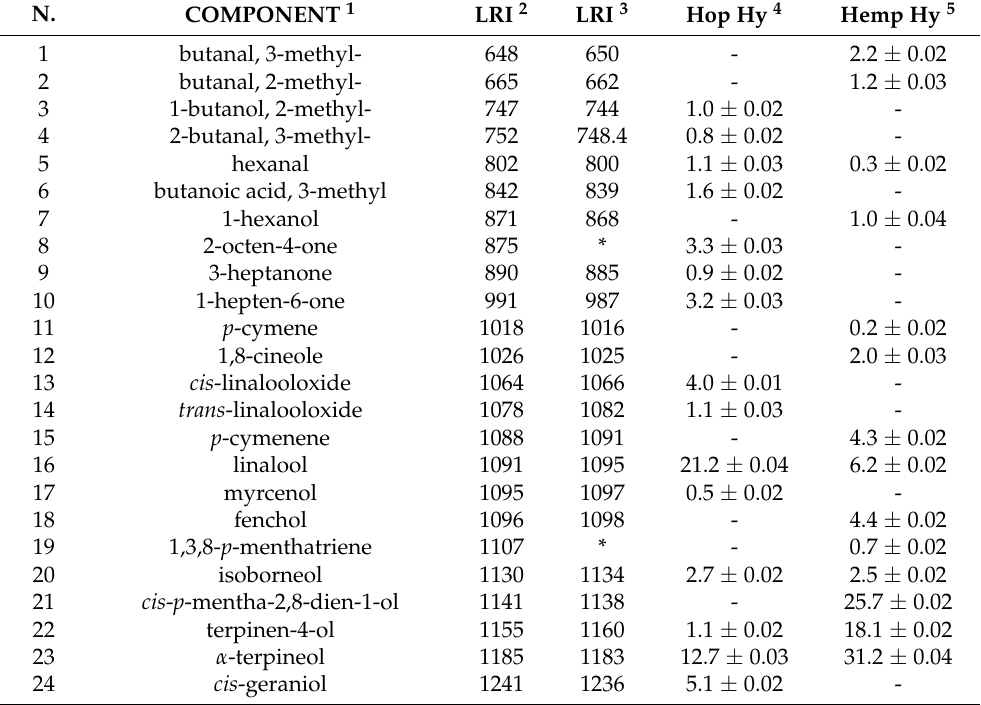
Table 2. Chemical composition (percentages mean values ± standard deviation) of hop and hemp Hy.